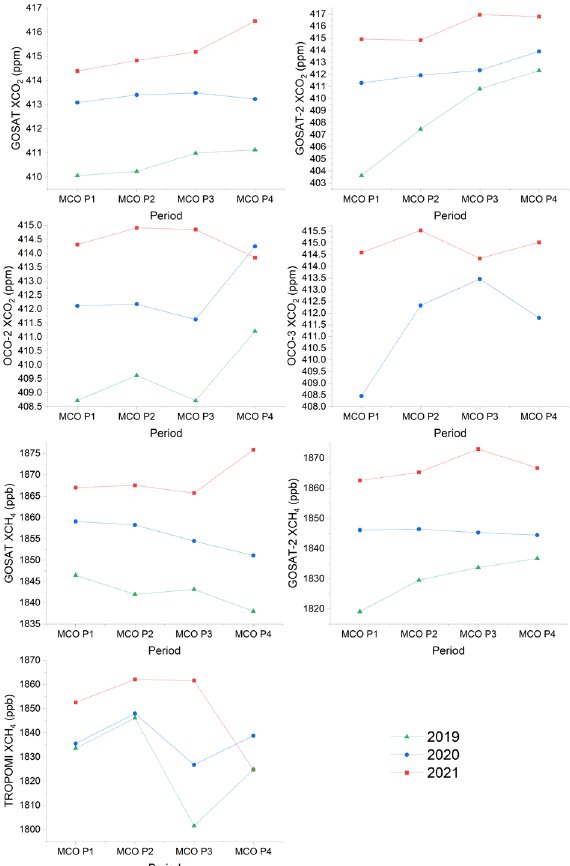
Figure 3. Average XCO 2 and XCH 4 during the period of MCO from 2019 to 2021.